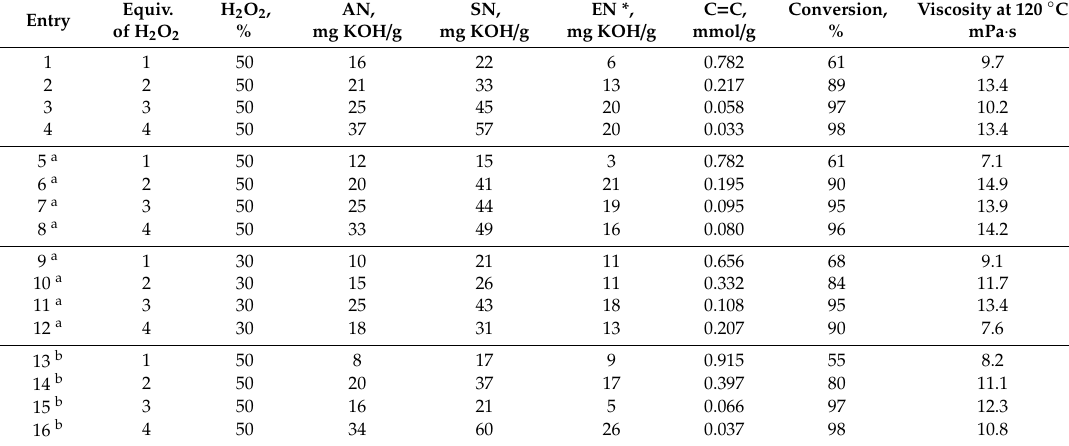
Table 1. E ff ect of amount and concentration of H 2 O 2 on the C30 + olefins